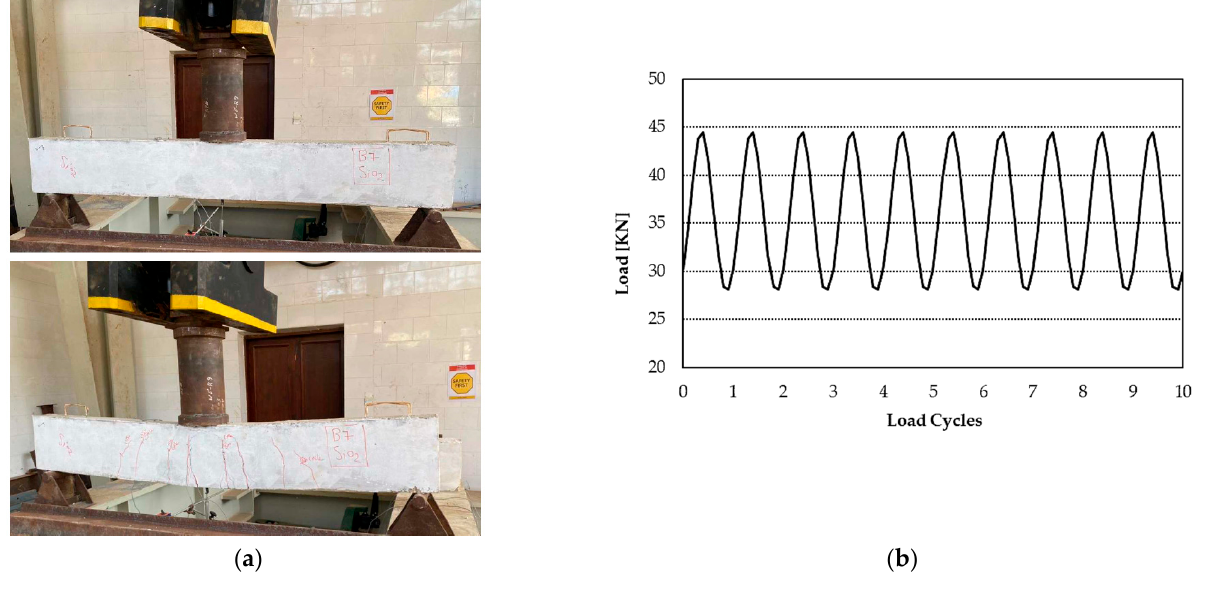
Figure 6. ( a ) Photo of a beam under the flexural cyclic loading; ( b ) Loading over 10 typical cycles.